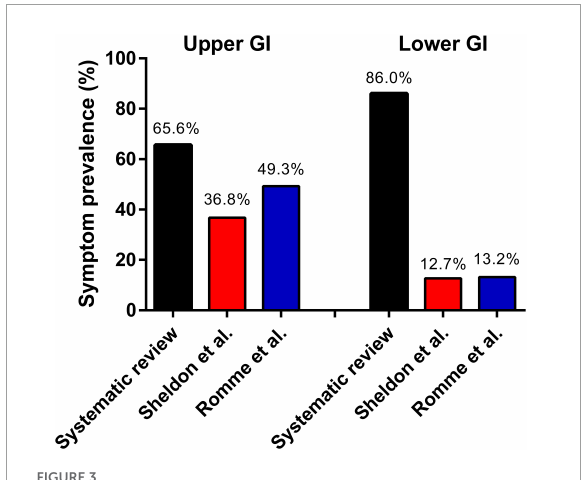
FIGURE3 Comparison of gastrointestinal symptoms in